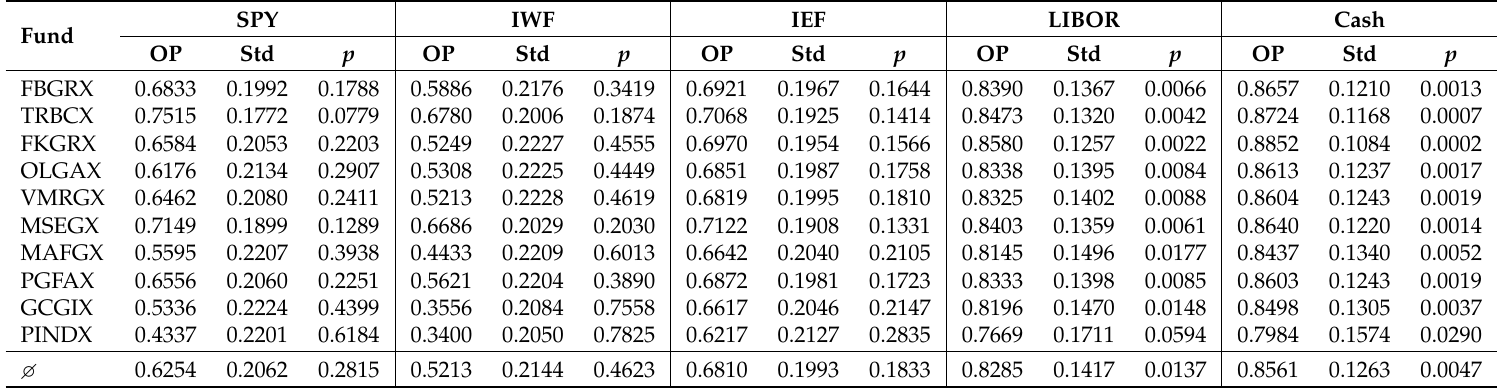
Table 5. Results in the case that T equals 5